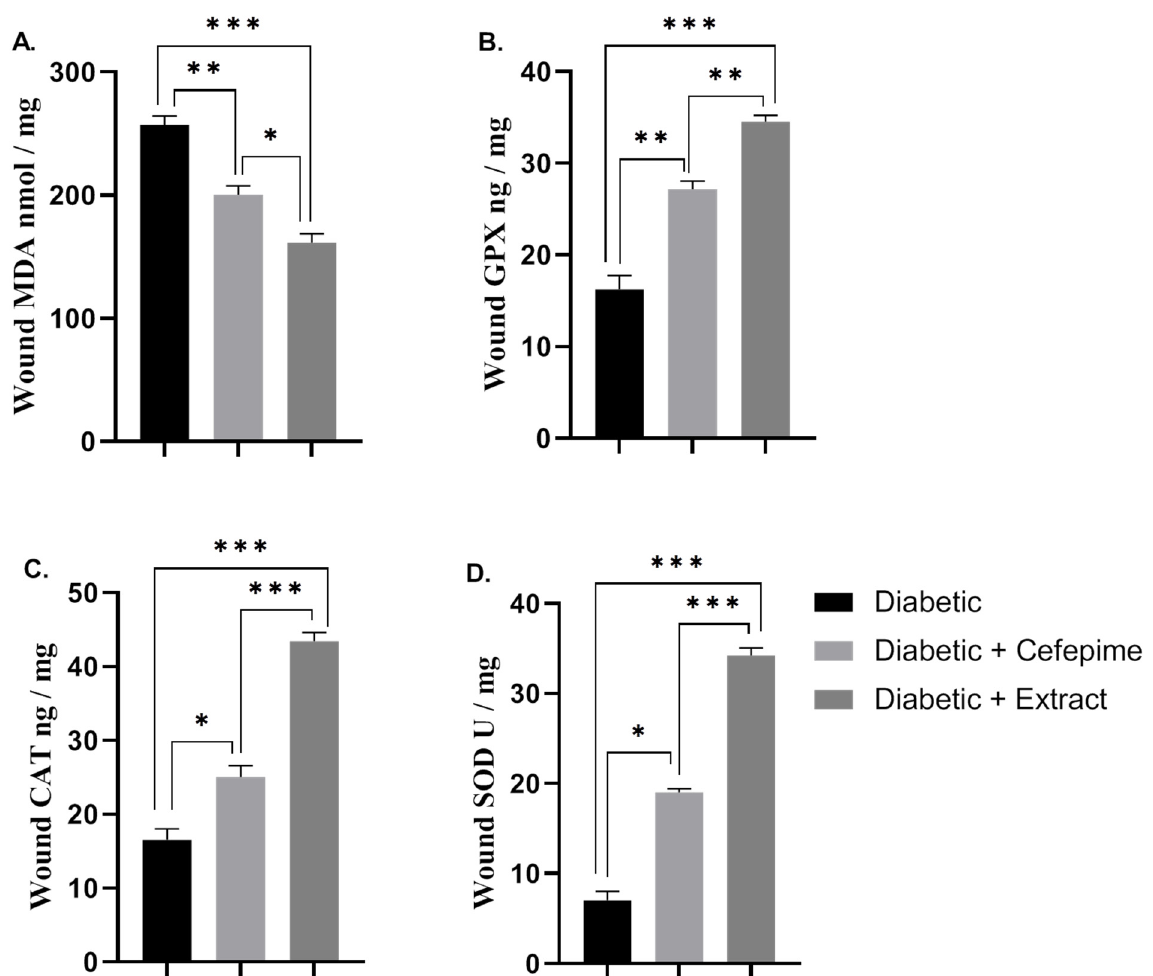
Figure 6. Effect of the hydrogel topical application of cefepime and CFE once daily for 14 successive days on the mean value of the oxidative status of the diabetic wound infected with P. Mirabilis in Type 1 diabetic rats ( A – D ). ( A ): lipid peroxidation marker (MDA nmol/mg), ( B ): GPx ng/mg, ( C ): CAT ng/mg, ( D ): SOD U/mg. *** Distinctive difference; ** Moderate difference; * Scant difference.